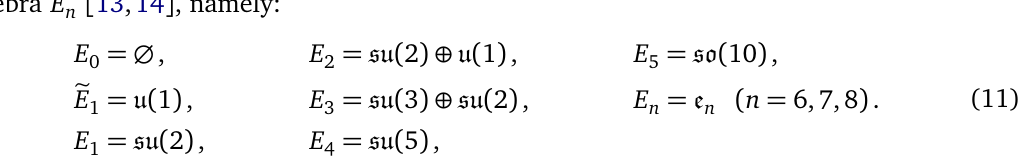
Table 3: Correspondence between E denotes the blow-up of the complex surface B can also be viewed as the Hirzebruch surface (cid:70) E E E n 0 1 (cid:101) B